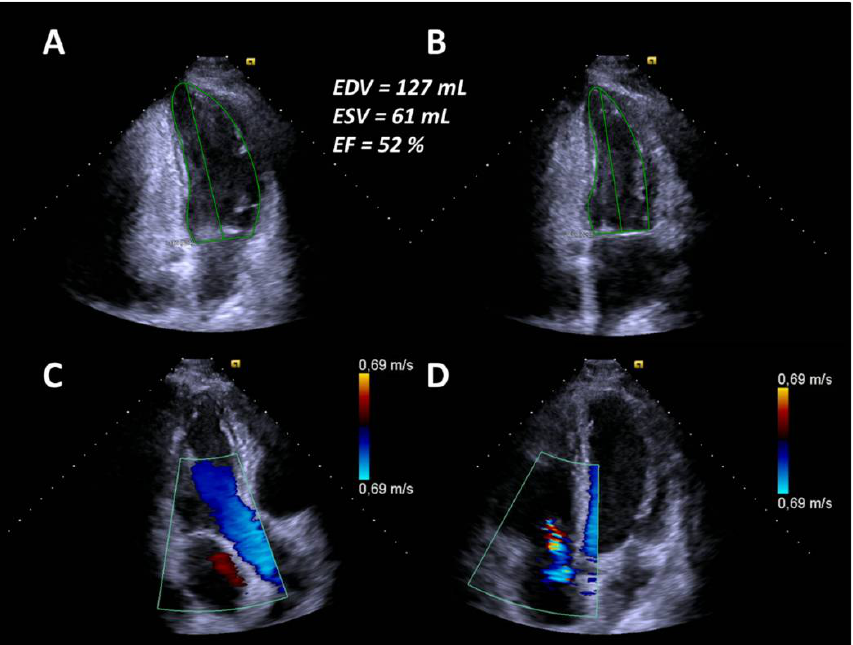
Figure 4. ( A ) End-diastolic borders of the left ventricle in the apical two-chamber view. ( B ) End-systolic borders of the left ventricle in the apical two-chamber view. ( C ) No mitral regurgitation in the apical three-chamber view. ( D ) Mild tricuspid regurgitation in the apical four-chamber view .